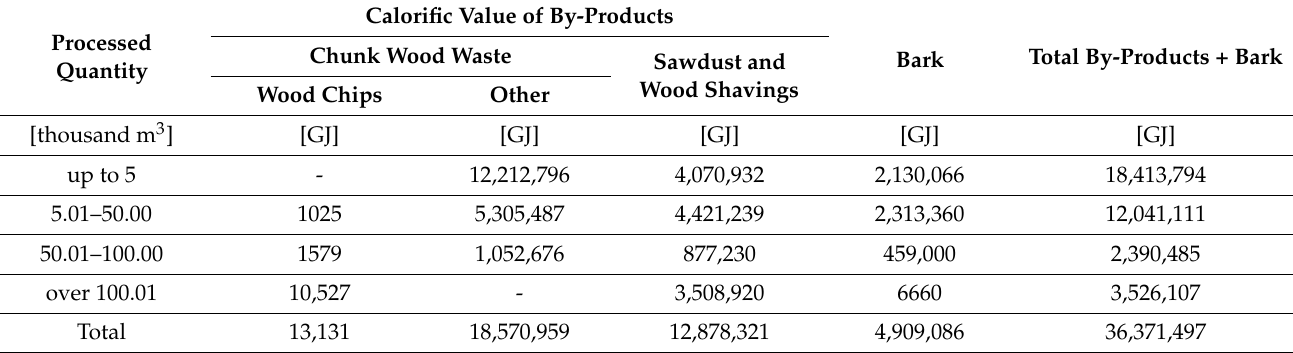
Table 8. Calorific value of by-products generated during wood processing by